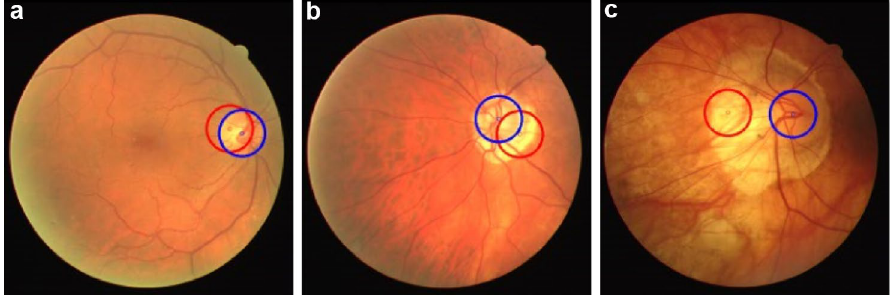
Fig. 5 Some optic disc detec- tion results